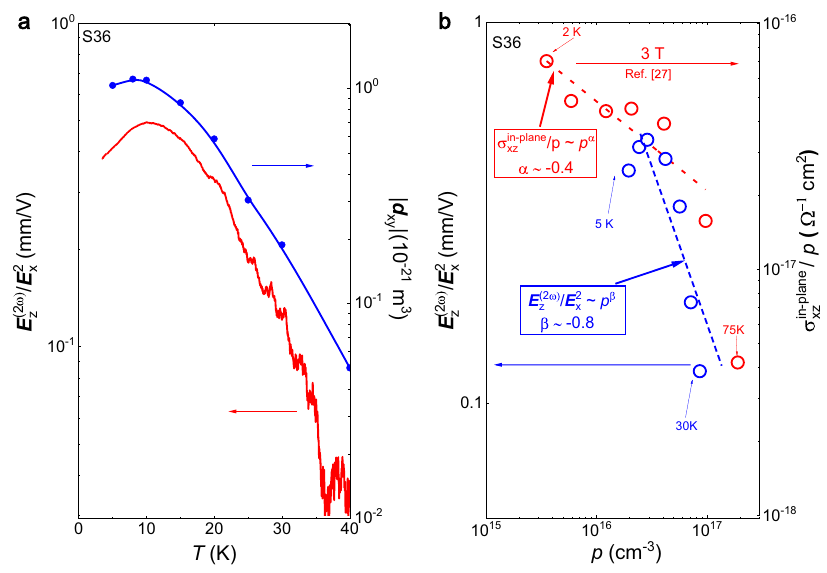
ω ð Þ z E 2 x and deduced Berry curvature dipole density σ in - plane = p are plotted against carrier concentration p . The blue and red dashed lines are xz